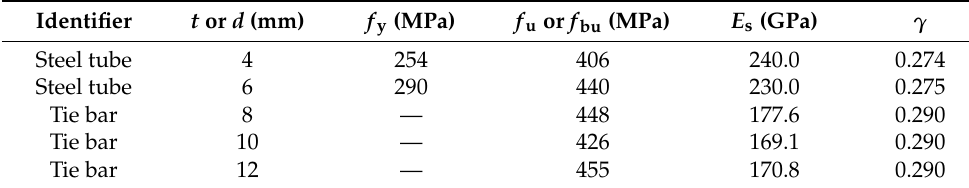
Figure 2. Steel specimens for tensile test. Table 2. Steel properties of the